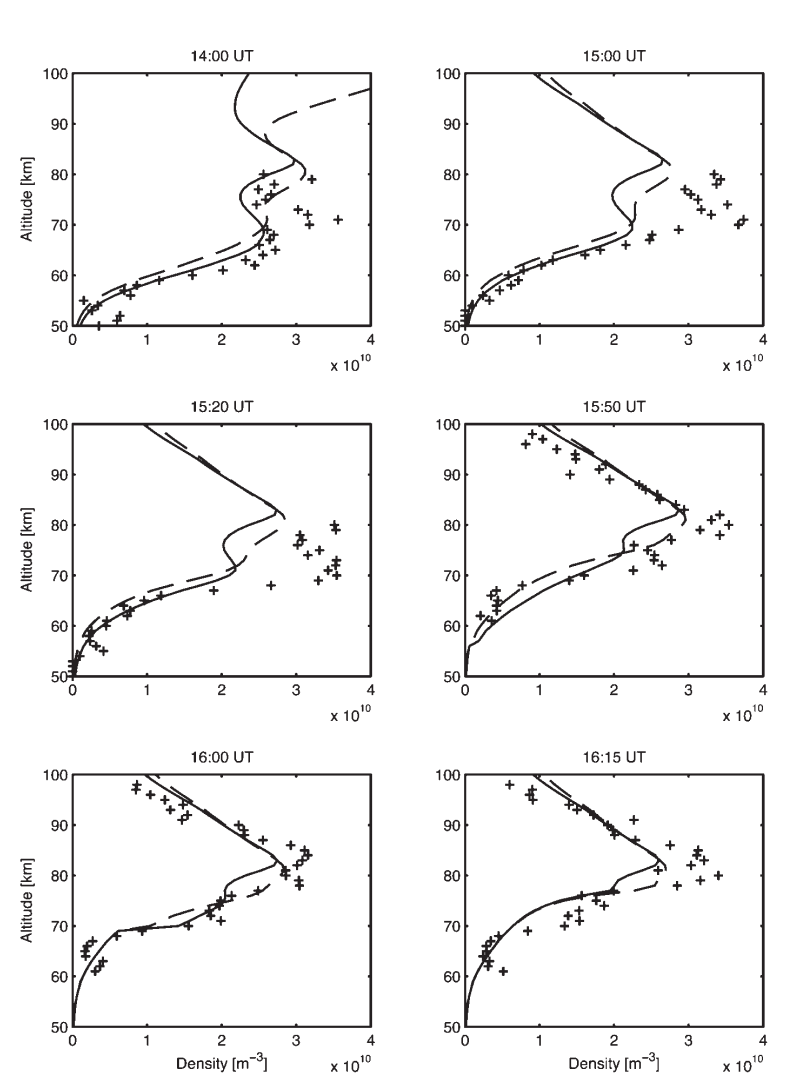
Fig. 14. The effect of the solar proton event on 23rd of October 1989 on D -region electron densities. Profiles are presented for selected times before, during, and after sunset. EISCAT incoherent scatter data are shown as crosses (+), and model electron densities using different (NO) profiles as solid and dashed lines (Verronen et al. ,